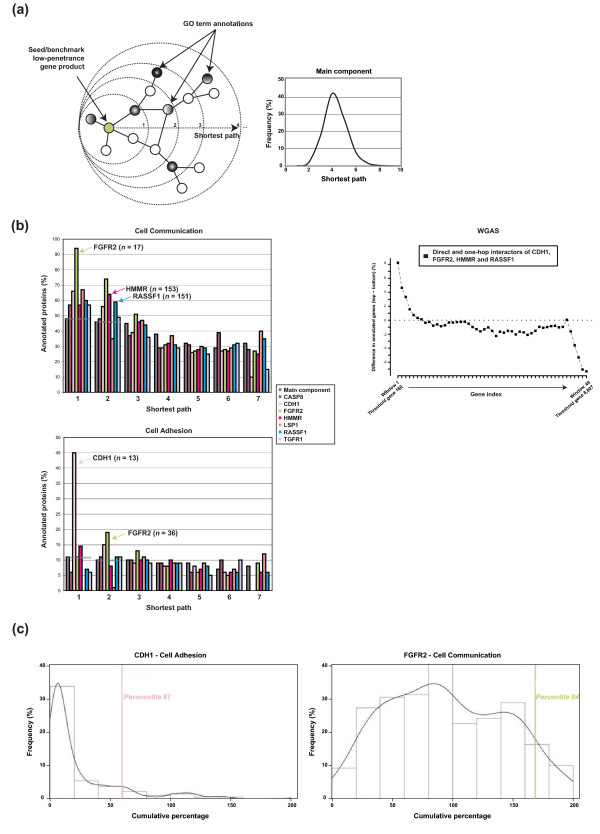
Same biological processes in the interactome network neighborhoods. (a) Left panel, strategy used to examine the interactome network; given a seed or benchmark protein encoded by a recognized low-penetrance susceptibility gene and using a shortest path algorithm, we calculated at each step the percentage of nodes annotated with Cell Communication or Cell Adhesion among proteins annotated with any term (excluding non-annotated proteins). Right panel, distribution of all possible short paths in the giant network component. (b) Left panels, results for percentages in short paths of up to seven steps for benchmark proteins. Over-representation in Cell Communication and Cell Adhesion annotations is suggested for CDH1, FGFR2, HMMR and RASSF1 at direct and/or one-hop interactions. Right panel, asymmetrical distribution of CDH1, FGFR2, HMMR and RASSF1 direct and one-hop interactors in the complete WGAS rank. (c) Over-representation of processes in the one-hop neighborhood of CDH1 or FGFR2 (vertical lines) using as controls seed proteins with the same Level 3 annotations (curves). The x-axis represents the cumulative percentage up to 200. The CDH1 and FGFR2 percentiles are shown.